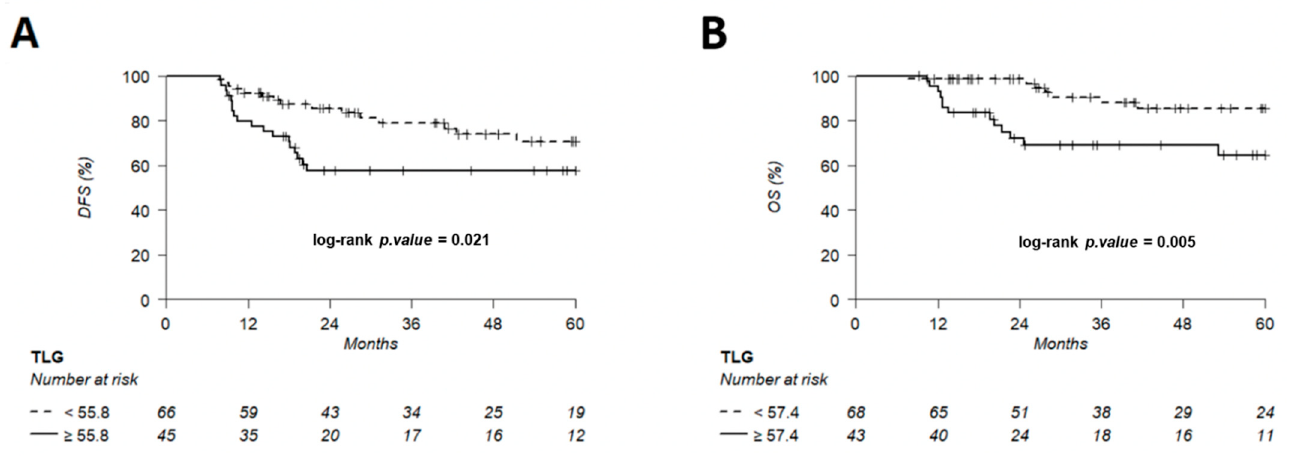
Figure 9. Kaplan–Meier of DFS ( A ) using a TLG threshold of 55.8 and OS ( B ) using a TLG threshold of 57.4, predetermined using Young’s index.